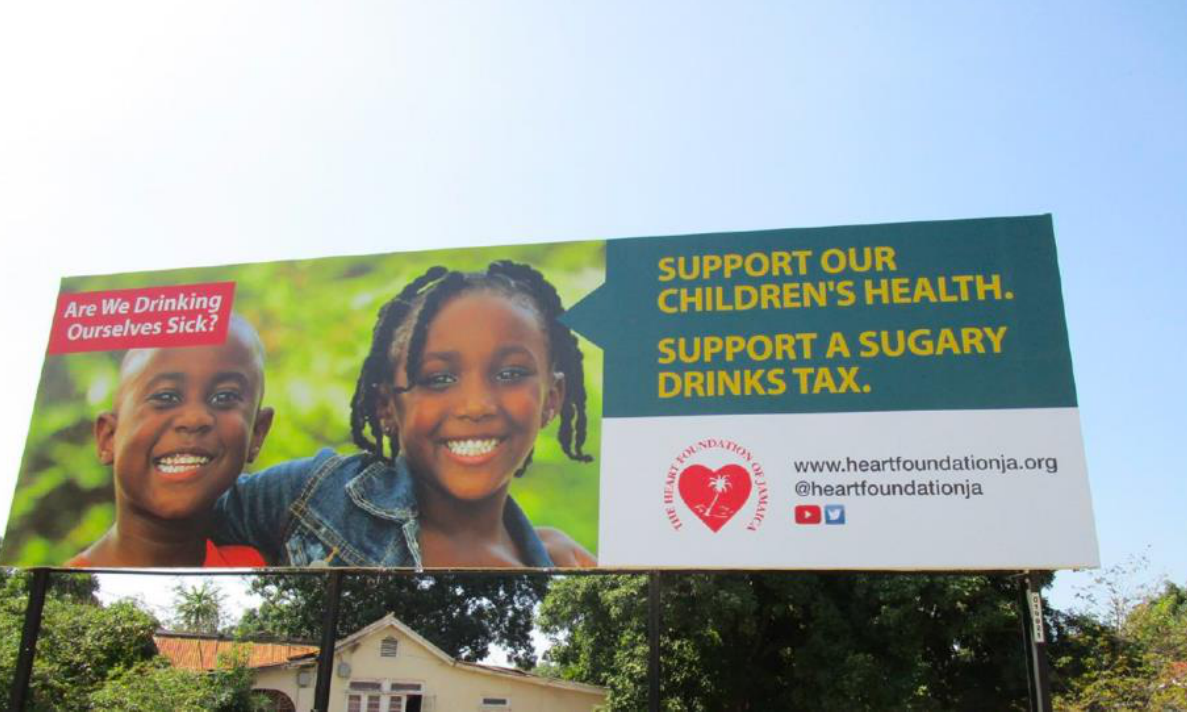
Figure 3. “Are We Drinking Ourselves Sick?” Communication Campaign Timeline. 2.2. Sample and Data Collection The three nationally representative face-to-face household surveys were conducted by the market research company, HOPE Caribbean Company Limited, under Vital Strat- egies’ guidance. A stratified multistage random sample design with quotas for age, gen- der, socioeconomic status, and location (urban/rural) from each stratum (parish, constitu- encies, areas, household) was used. The country was stratified into 14 parishes, which were further stratified into constituencies and then into two areas within each